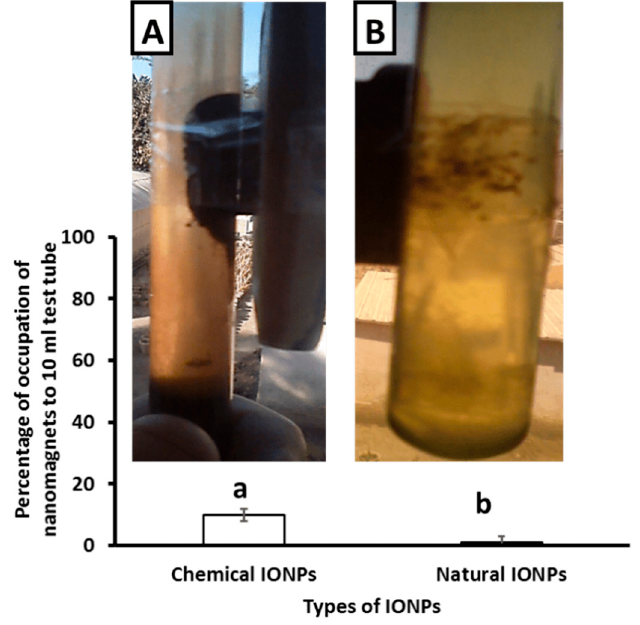
Figure 1. The magnetic property of IONPs prepared using chemical method ( A ) and Petroselinum crispum leaf extract ( B ). Values are expressed as mean ± standard deviation (SD; n = 10).